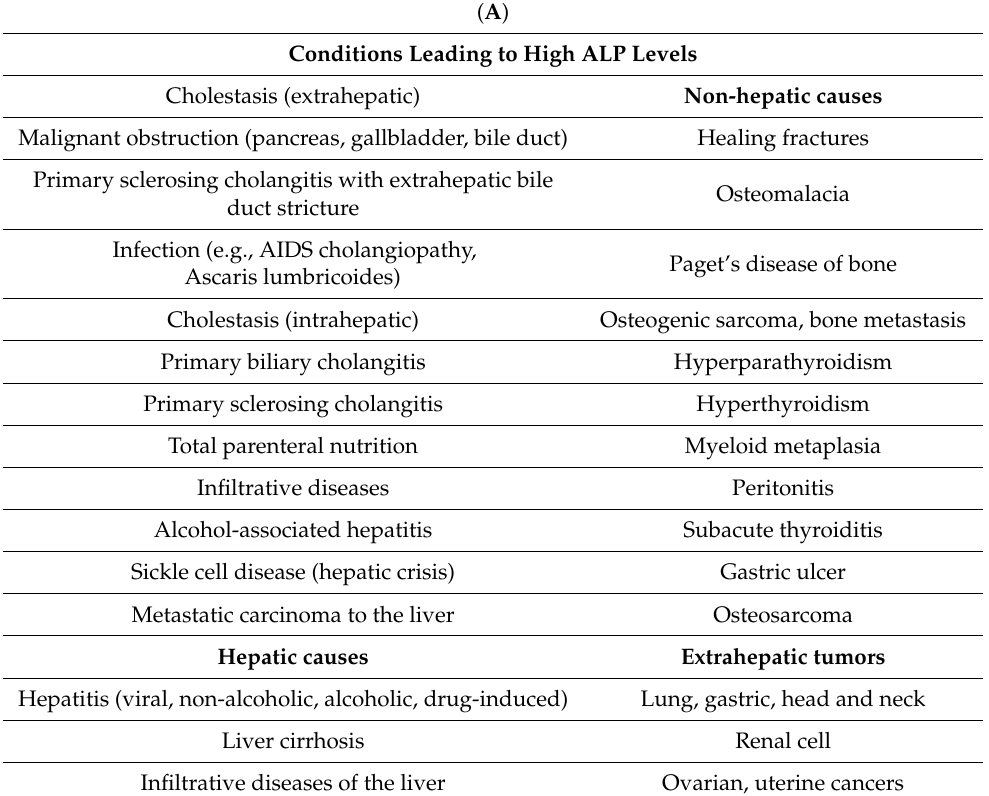
Table 1. Conditions associated with abnormal (A. elevated, B. reduced) serum levels of